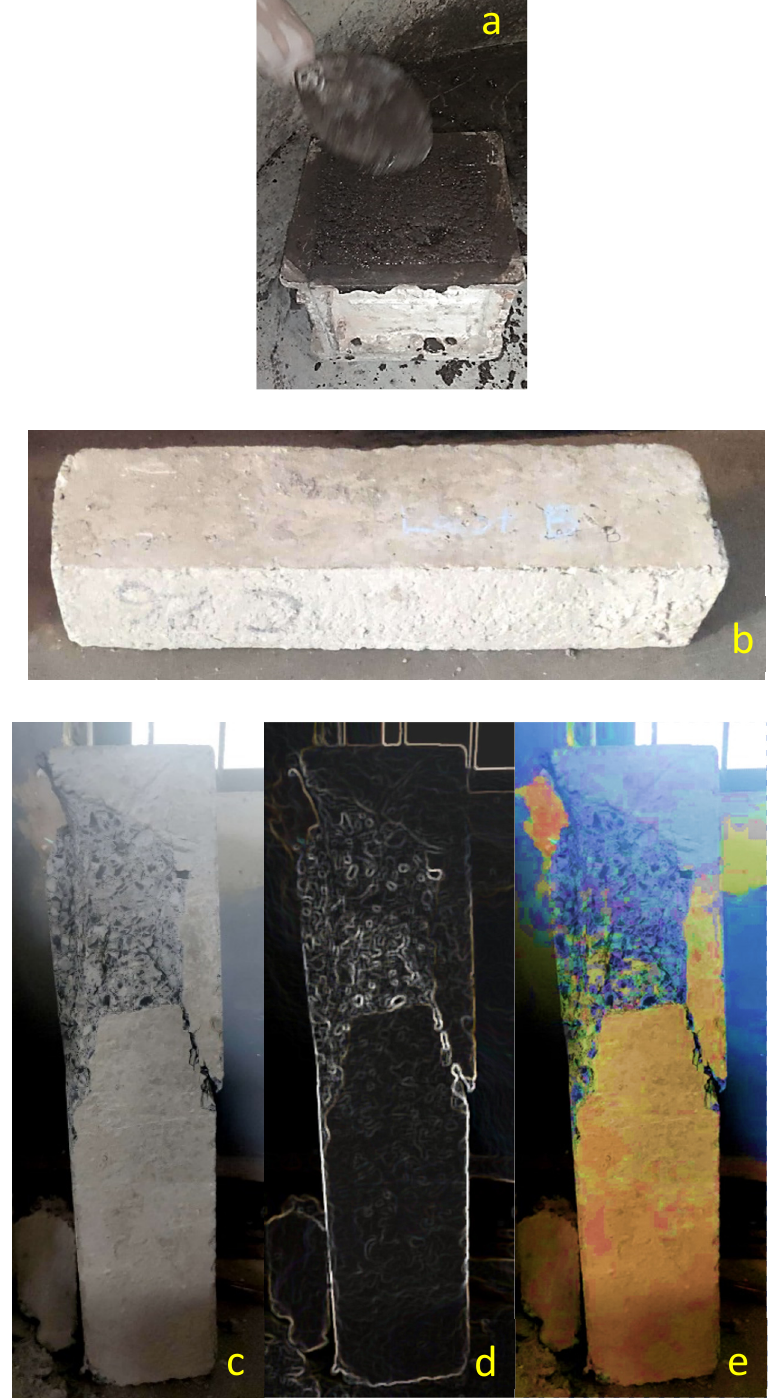
Figure 2. ( a ) Cast of the cube for compressive strength testing. ( b ) Beam specimens before flexural testing. ( c ) Beam specimens after flexural testing. ( d , e ) Failure pattern on the surface of the beam.